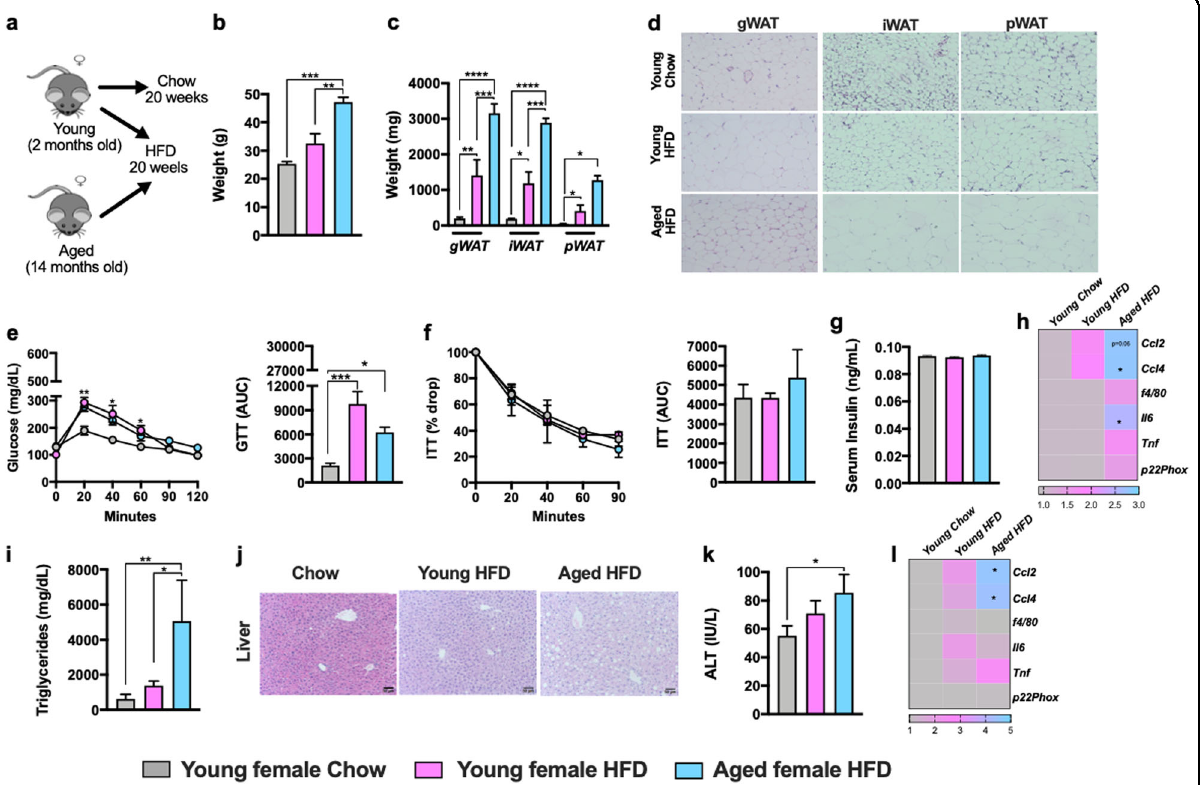
Fig. 2 HFD ampli fi es aging-associated weight gain and uncovers aging-dependent skewing of metabolic disease severity in female mice. 2-month-old (Young) and 14-month-old (Aged) female C57BL/6 mice, ( n = 3 – 5/condition) were housed at 22 °C (T S ) and fed Chow or HFD for up to 20 weeks. a Schematic representation of DIO model used. b Body weight at time of harvest. c White adipose tissue (WAT) weight: gonadal WAT (gWAT), inguinal WAT (iWAT) and perirenal WAT (pWAT). d gWAT, iWAT and pWAT hematoxylin eosin (H&E) staining. e Left, glucose tolerance test (GTT) and Right, GTT area under the curve (AUC). f Left, insulin tolerance test (ITT) and Right, ITT area under the curve (AUC). g Serum insulin levels. h Liver triglycerides. i Liver H&E staining. j Serum Alanine transaminase (ALT) levels. k Heatmap of WAT mRNA levels of Ccl2, Ccl4 , f4/80 , Il6, Tnf and p22phox fold change relative to chow diet fed young female. l Heatmap of hepatic mRNA levels of Ccl2, Ccl4 , f4/80 , Il6, Tnf and p22phox . A